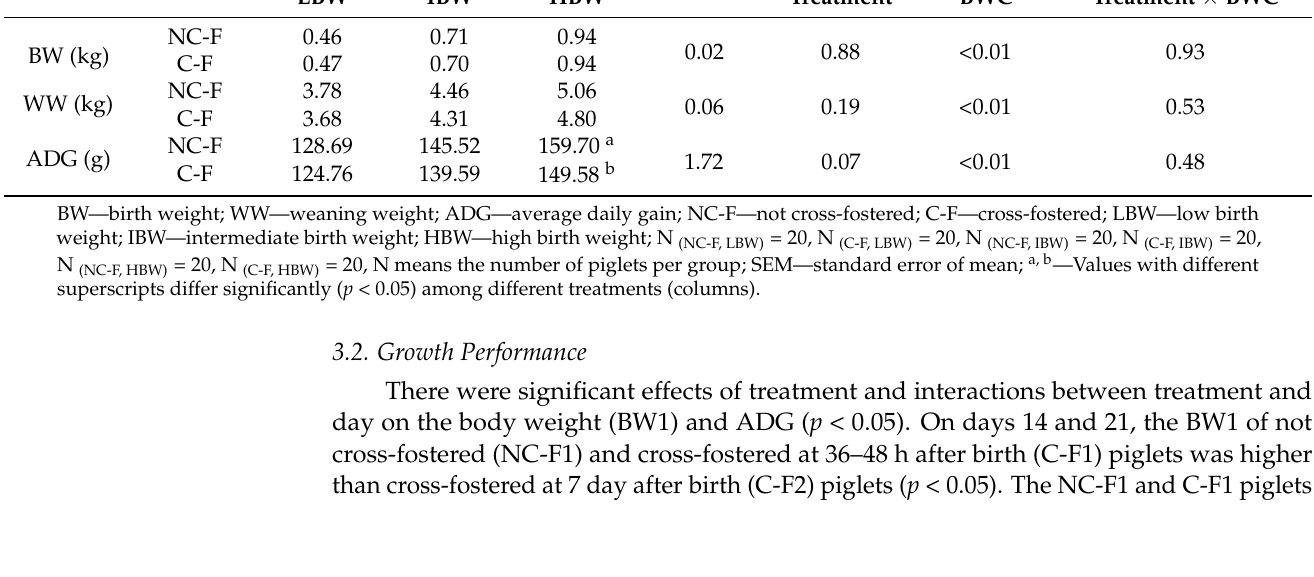
Table 1. The effect of different piglets’ birth weight through cross-fostering on the BW, WW and ADG of piglets.